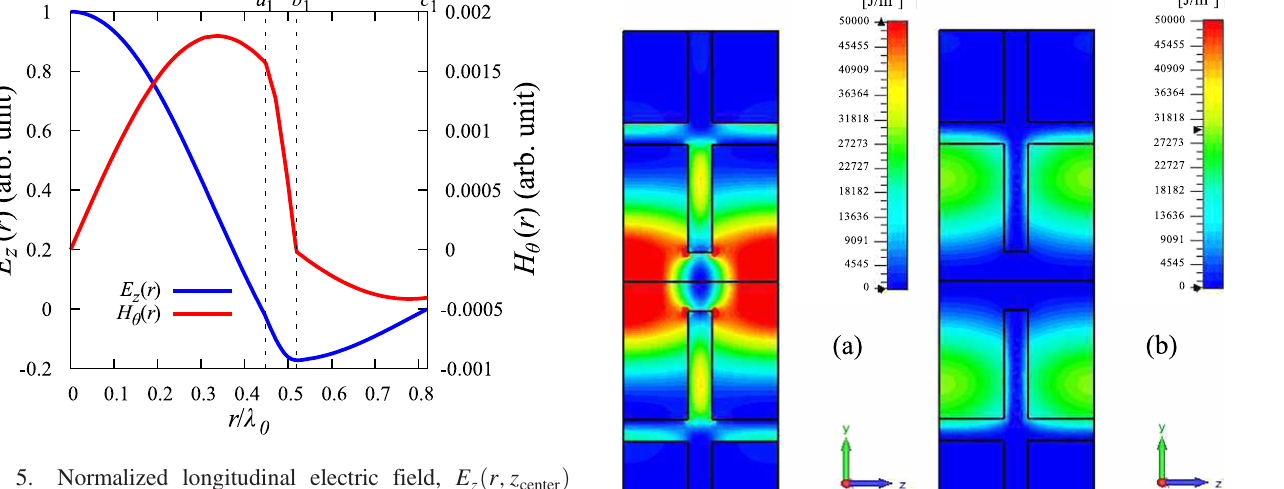
center Þ (red line) center Þ FIG. 6. (a) Energy density in an electric field of the accelerating mode. (b) Energy density in a magnetic field of the accelerating mode. These distributions of energy density are shown in arbitrary units.